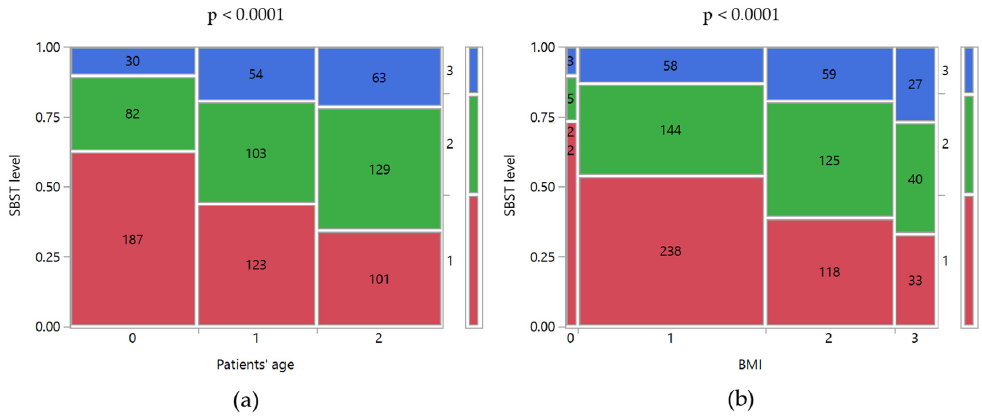
Figure 3. Mosaic plots of SBST levels versus ( a ) Patient’s age and ( b ) BMI. SBST levels: 1, low; 2,